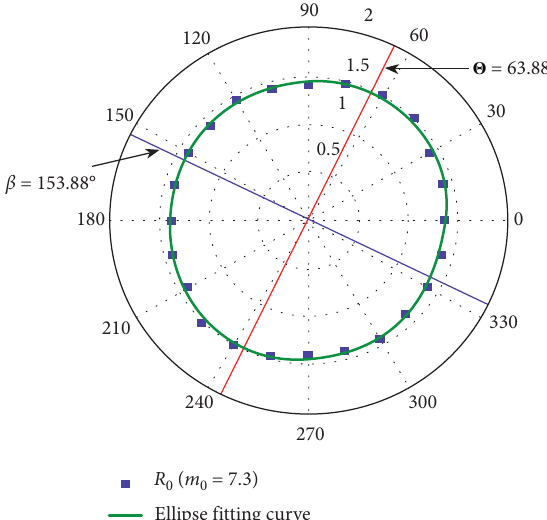
Figure 2: Polar plots of the processed JRC values by m